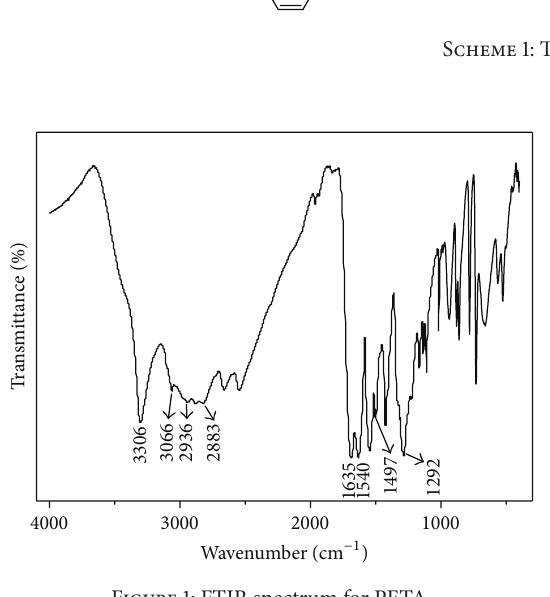
Figure 1: FTIR spectrum for PETA.